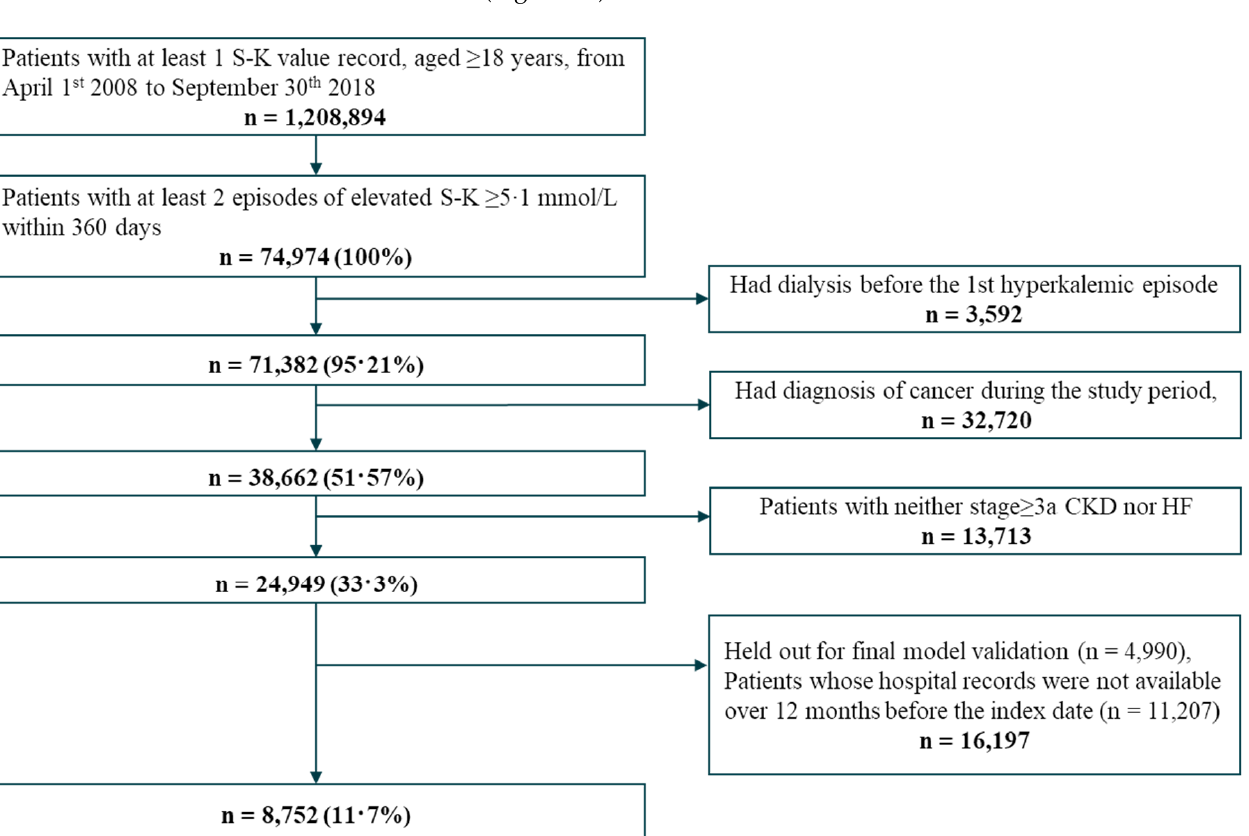
Table 1. Characteristics of patients at the first hyperkalemic episode in the derivation, internal val- idation, and external validation sets.